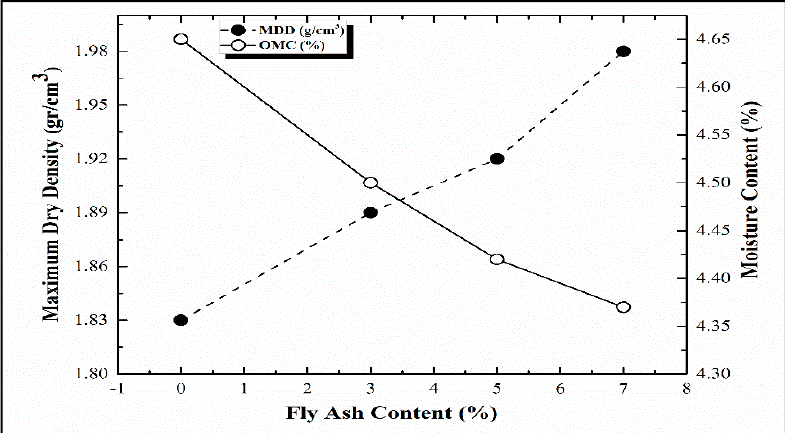
Figure 4. Effect of FA on the compaction of cement-modified desert soil (50:50).